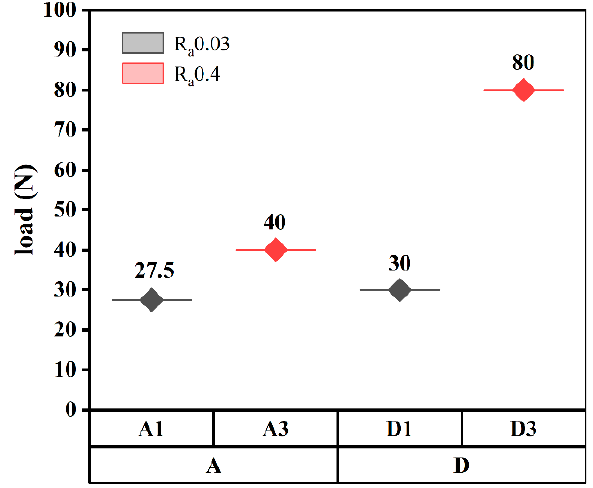
Figure 7. Diamond film separation load threshold.